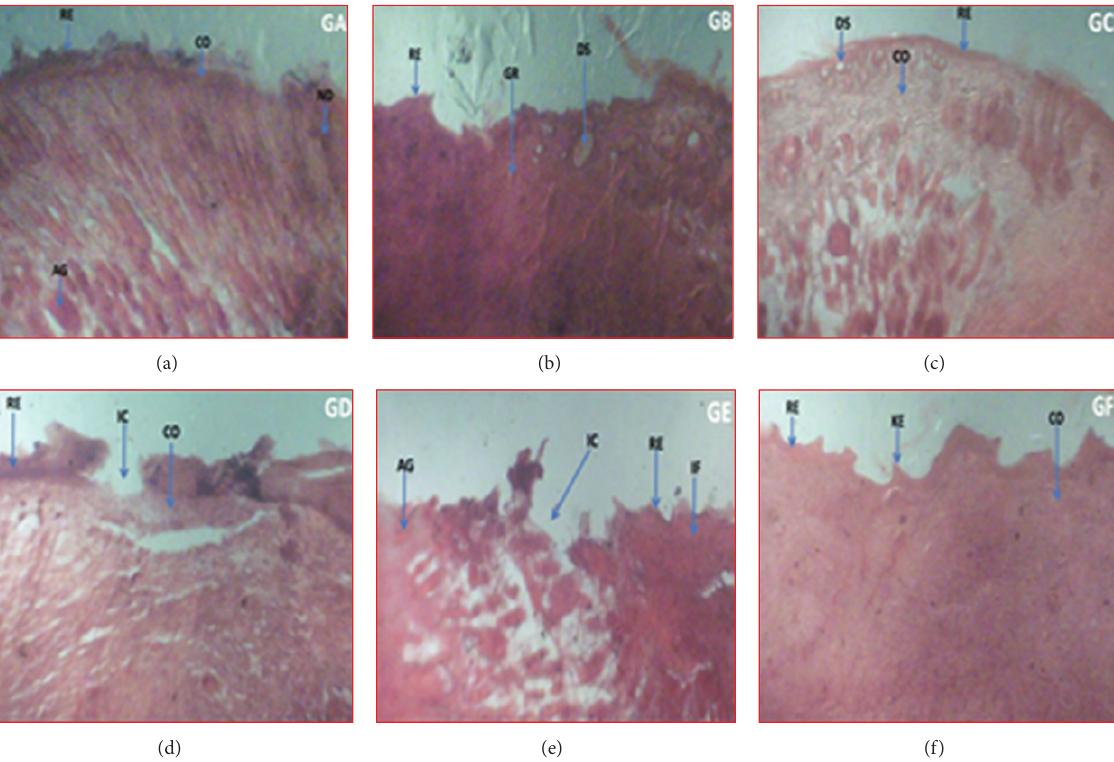
Figure 10: Histopathological examination of wound tissues treated with vehicle, extracts, and the untreated tissues. Representative images stained with hematoxylin and eosin stain, Van Gieson’s stain and toluidine blue stain treated daily with 7.5% w/w creams of methanol leaf extract (KAL) of K. africana (a), methanol stem bark extract (KASB) of K. africana (b), methanol leaf extract (SHL) cream of S. hispidus (c) and methanol root extract (SHR) cream of S. hispidus (d) and the untreated wound tissues (e) for 14 days. (a) KAL: profuse angiogenesis, enhanced collagenation, and reepithelialization, evident of marked treatment responses amidst persistent inflammation. (b) KASB: appreciable angiogenesis and granulation tissue formation with evidence of apoptosis following tissue necrosis with less intense collagenation and reepithelialization. (c) SHL: With appreciable intense collagenation and reepithelialization. (d) SHR: With appreciable granulation tissue formation manifested as tissue refilling. Collagenation and re-epithelialization were also in earnest compared to the untreated wound tissue. (e) Untreated wound tissues with persistent inflammation with incomplete wound area; evidence of poor granulation tissue formation, collagenation and reepithelialization but profuse angiogenesis. (f) Treated wound tissues with 1% w/w silver sulphadiazine showed rapid granulation tissue formation, collagenation, evident of enhanced wound healing and uneven keratinous wound surface evident reepithelialization. Legend: AG: angiogenesis, CO: collagenation, DS: dead space following necrosis, GR: granulation tissue following apoptosis, IC: incomplete wound area, IF: inflamed tissue, KE: keratinous epithelium, ND: necrotic debris of persistent inflammation. RE: